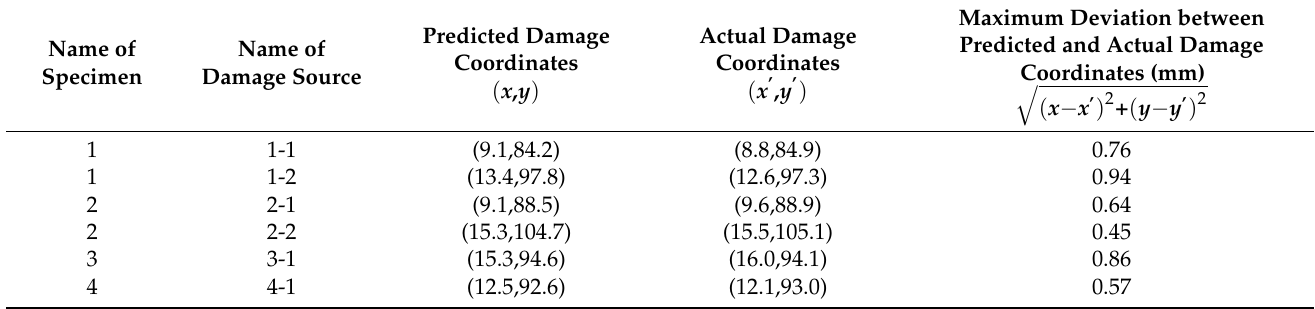
Table 5. Predicted and actual coordinates of damage in braided